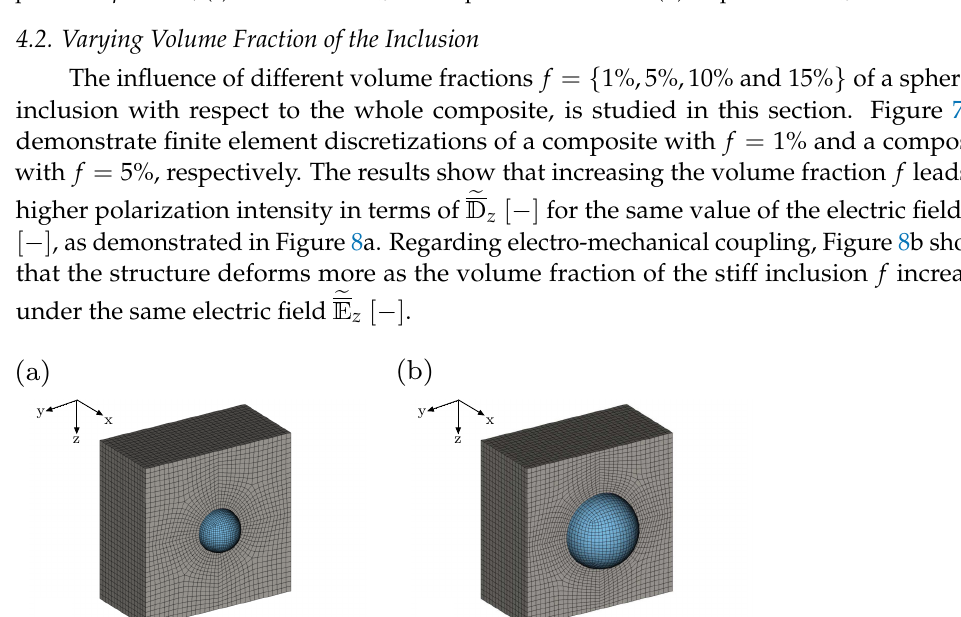
Figure 6. Finite element simulation of the heterogeneous structure at (cid:101) D z = 1.75 [ − ] and θ init = 298 Kelvin, showing the contour map of ( a ) absolute temperature θ in Kelvin, ( b ) electric potential φ in Volt, ( c ) electric field E z in Volt per millimeter and ( d ) displacement u z in millimeter.